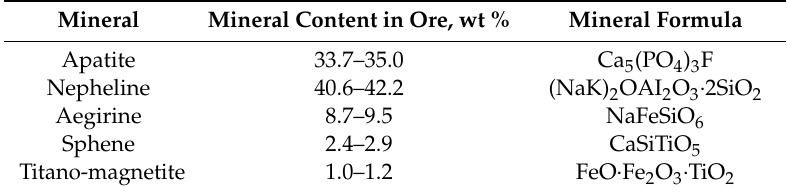
Table 1. The main minerals composing apatite-nepheline ores (ANO).